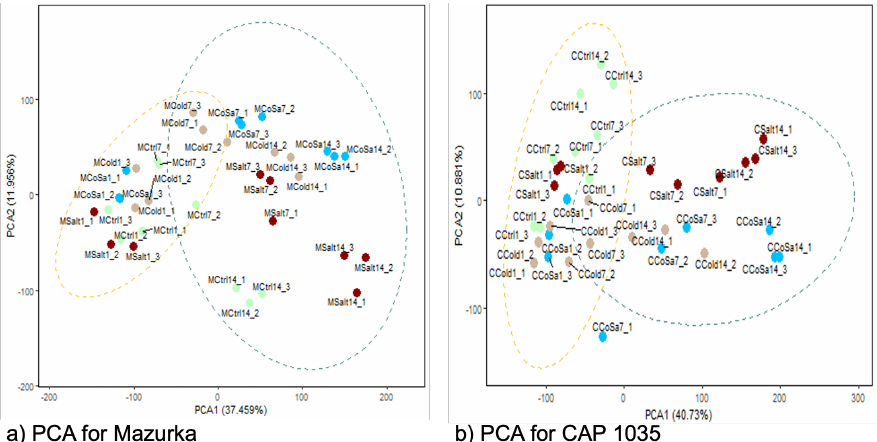
( b ) indicating responsiveness to the harvest time points and stress treatments, shown by comparison of principal component 1 (PC1) versus principal component 2 (PC2). Control = green, cold = light brown, salt = red, CoSa =